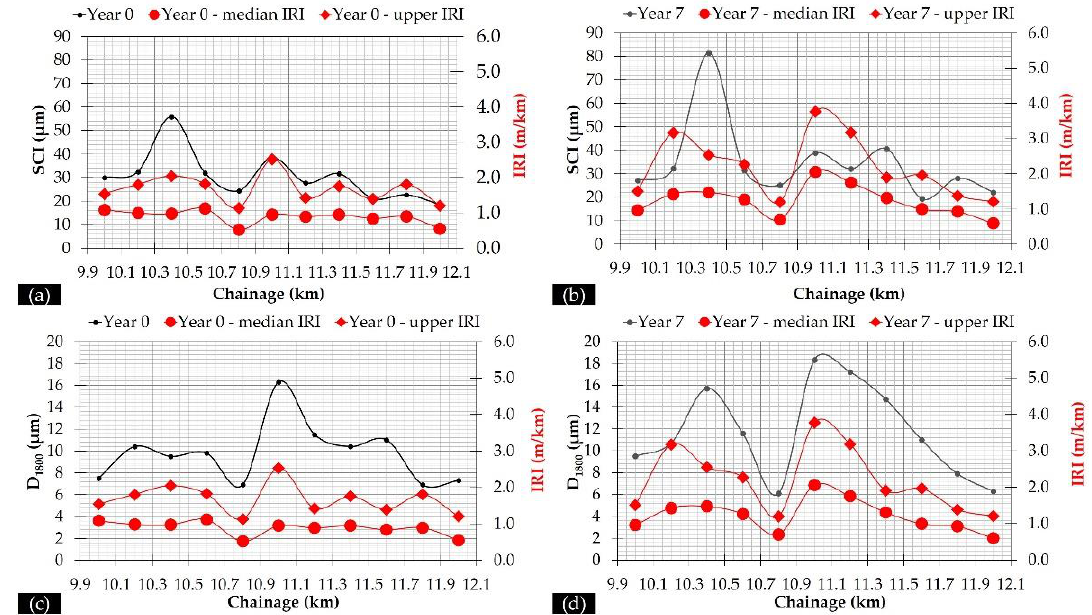
Figure 10. Relationship between ( a ) SCI and IRI, year 0, ( b ) SCI and IRI, year 7, ( c ) D 1800 and IRI, year 0, and ( d ) D 1800 and IRI, year 7.